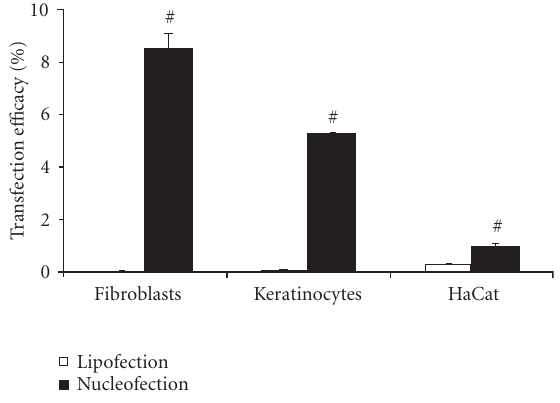
Figure 2: Histological analysis . The transfection e ffi cacy of the FuGENE6-enhanced lipofection (white bars) and the Amaxa nu- cleofection techniques (black bars) are displayed. X-gal stained cells were counted in 10 high-power fields (HPF) at 200-fold magnifica- tion and extrapolated on positive cells/well. Positive cells were cor- related to the number of cells used per well. #: ( P < . 05) nucleofec- tion versus lipofection. Data are displayed as mean (cid:0)